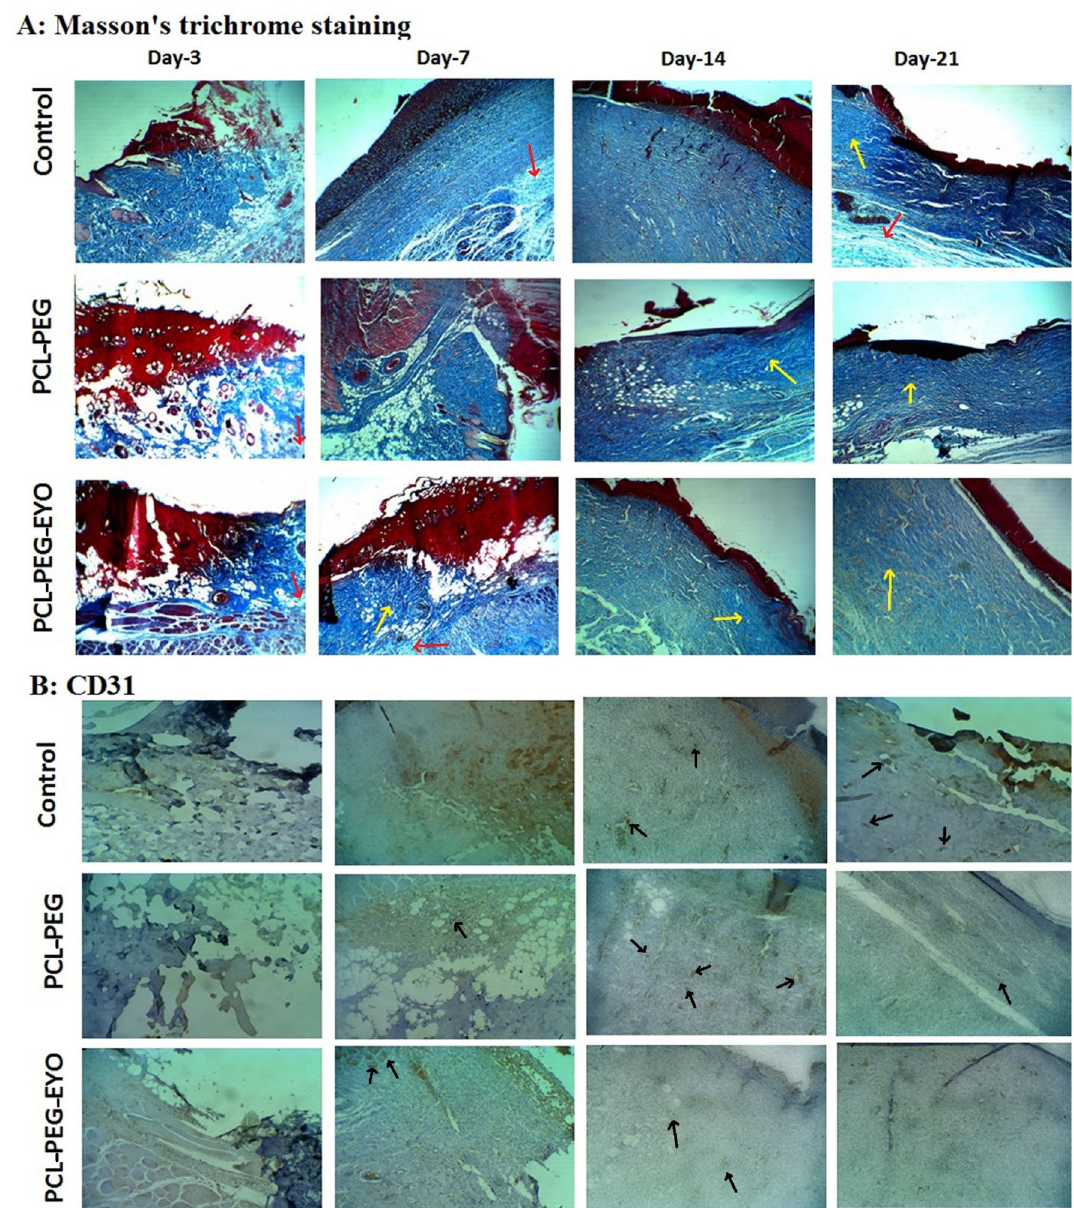
Figure 6. ( A ) Masson’s trichrome staining (100x) and ( B ) CD31 marker for investigating of collagen synthesis (Red arrows: fine collagen fibrils; Yellow arrows: collagen fibers) and angiogenesis (Black arrows) histology of burn wound tissue in control group, PCL-PEG and PCL-PEG-EYO nanofibrous scaffold at different time-point post